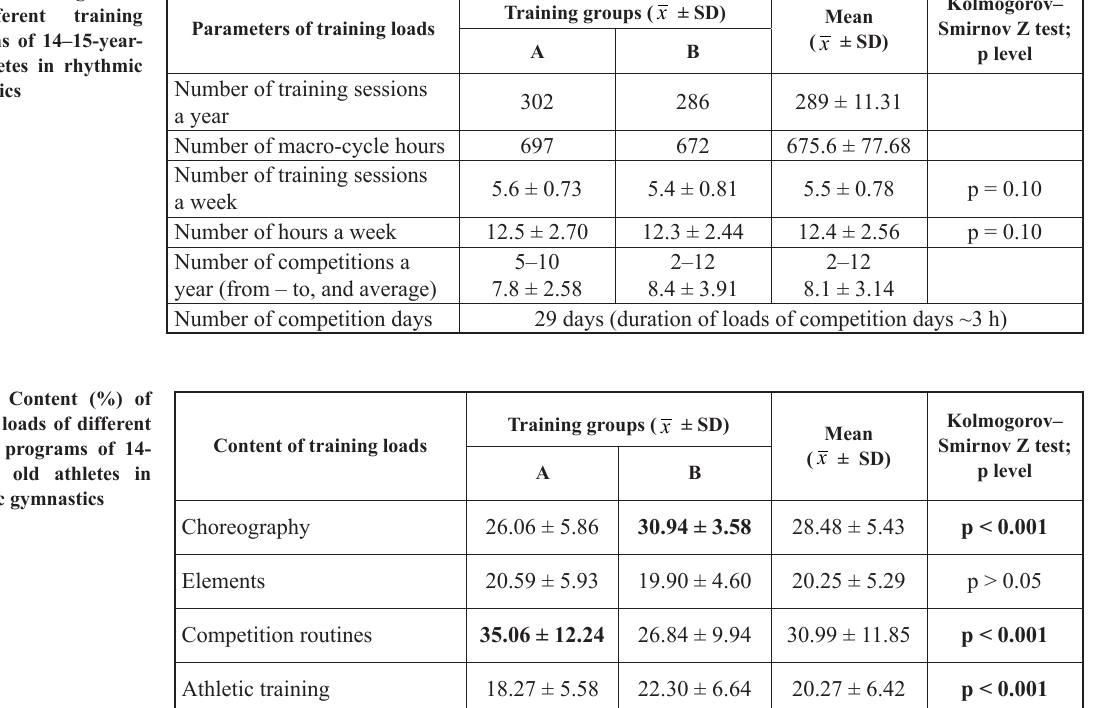
Table 2. Training loads of different training programs of 14–15-year- old athletes in rhythmic gymnastics